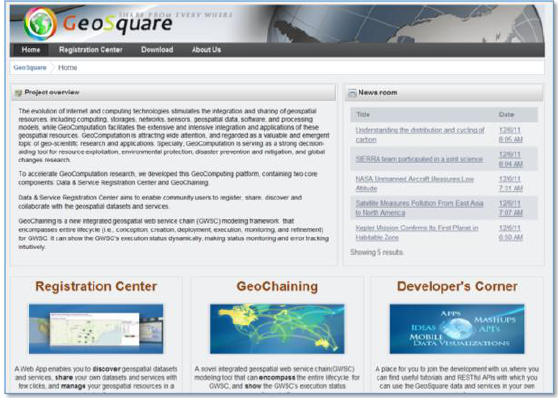
Figure 2. The user interface of GeoSquare.